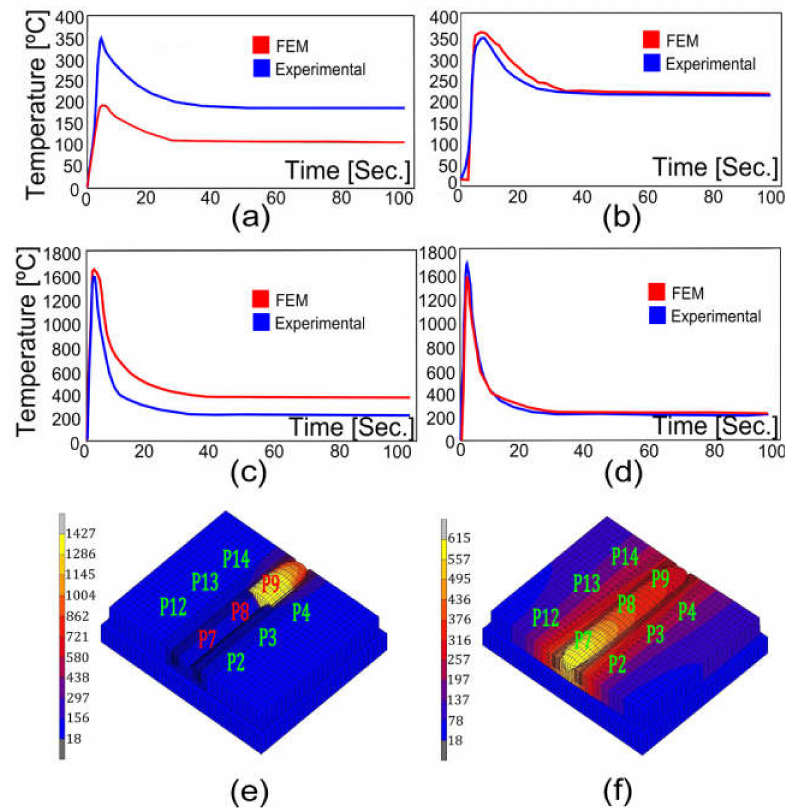
Figure 9. Temperature: ( a ) Of key node P14 without having adjusted the parameters of the FE model; ( b ) Of key node P9 without having optimized the parameters of the FE model; ( c ) Of key node P14 with the parameters of the FE model optimized; ( d ) Of key node P9 with the parameters of the FE model optimized; ( e ) Field after three seconds for the first welded joint FE model studied; and, ( f ) Field after 30